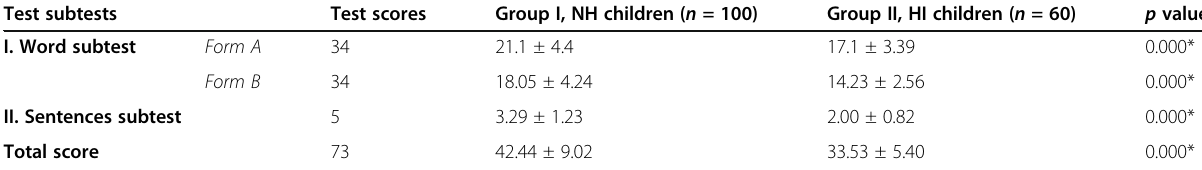
Table 5 Comparison of the Arabic lipreading test scores among the NH and HI children, using the paired t test Test subtests